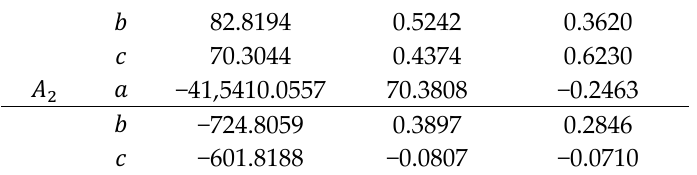
Table 7. Binary parameters 𝐴 0 , 𝐴 1 , and 𝐴 2 of the equation 𝑉 𝑗𝑘𝐸 = 𝑥 𝑗 𝑥 𝑘 ∑